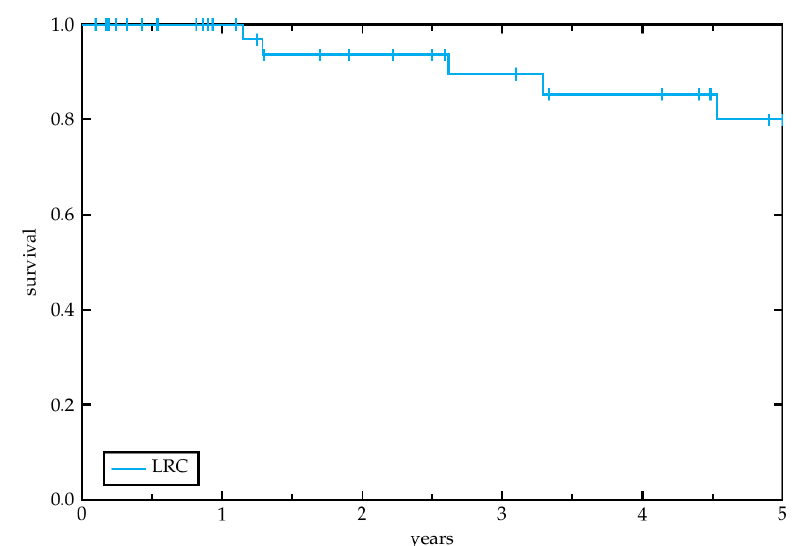
Figure 1. Locoregional control. Kaplan-Meier plot showing locoregional control of the 46 patients, enrolled in this study, within a 5-year period after radiotherapy initiation.